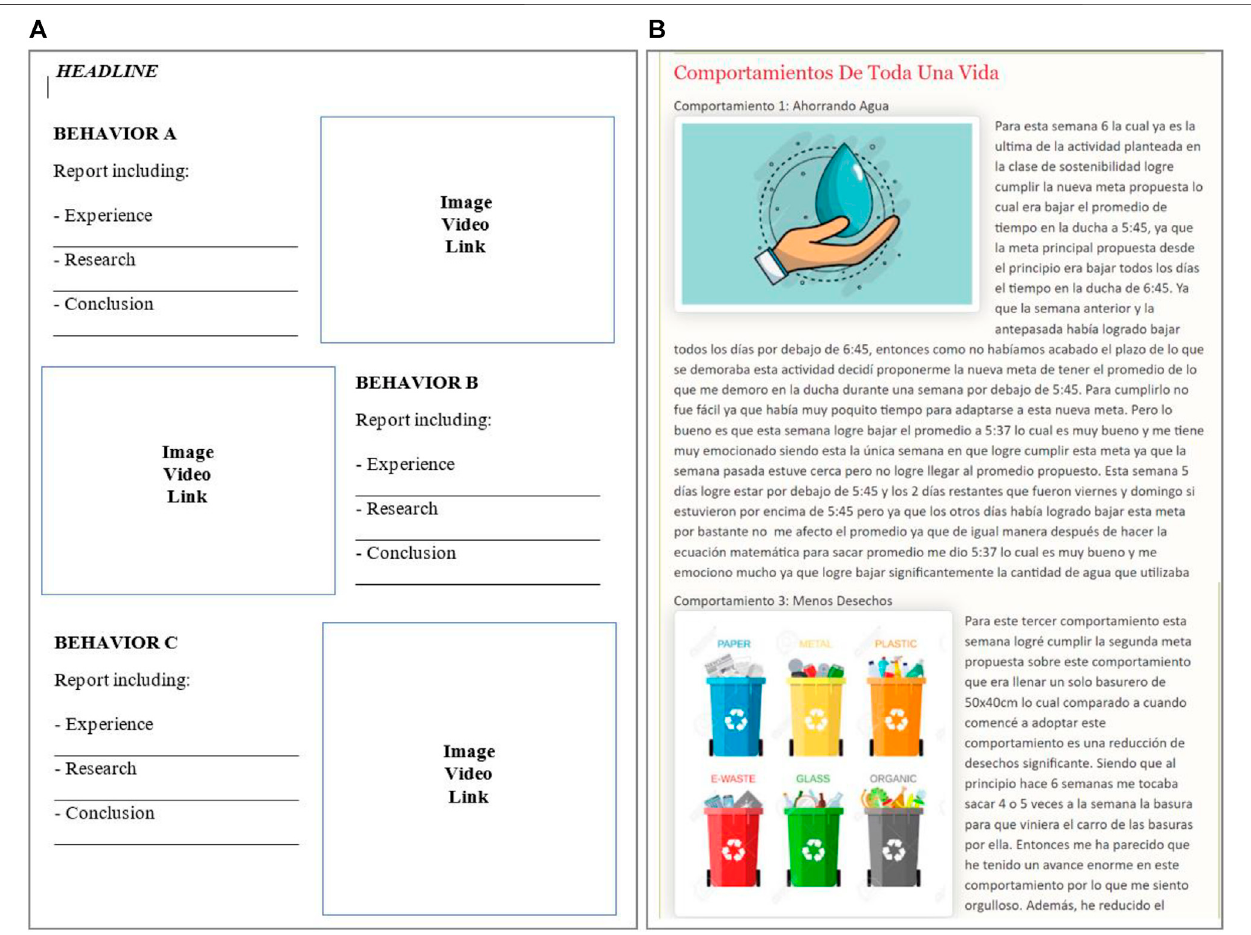
FIGURE 7 | shows: (a) The publication/post model with the three dimensions; (b) An example of a publication/post made by the students.